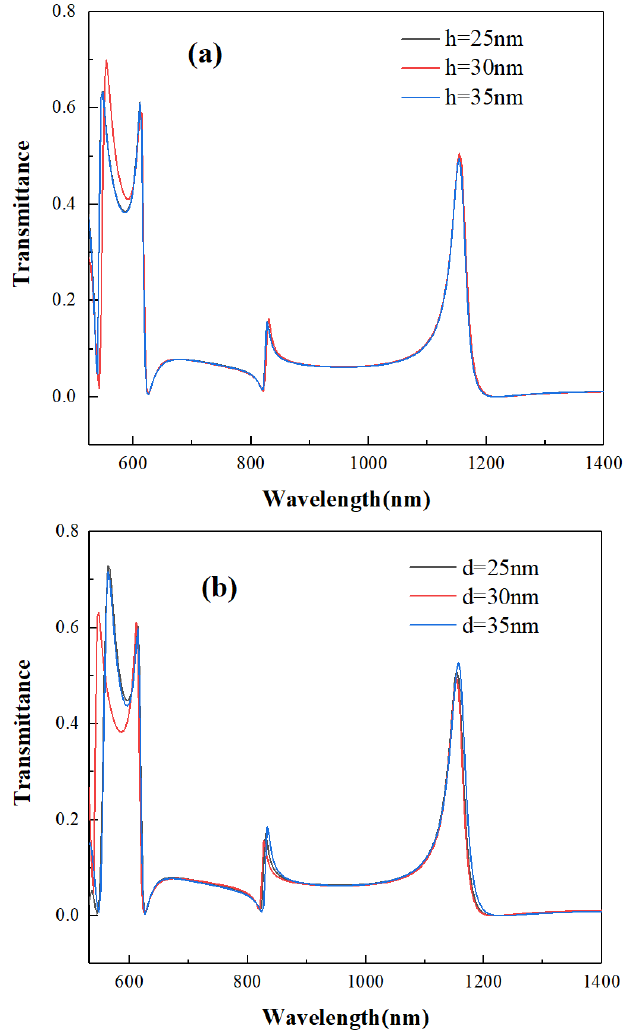
Figure 5. Transmission spectra of the structures with different ( a ) heights and ( b ) widths of the rectangular stubs.